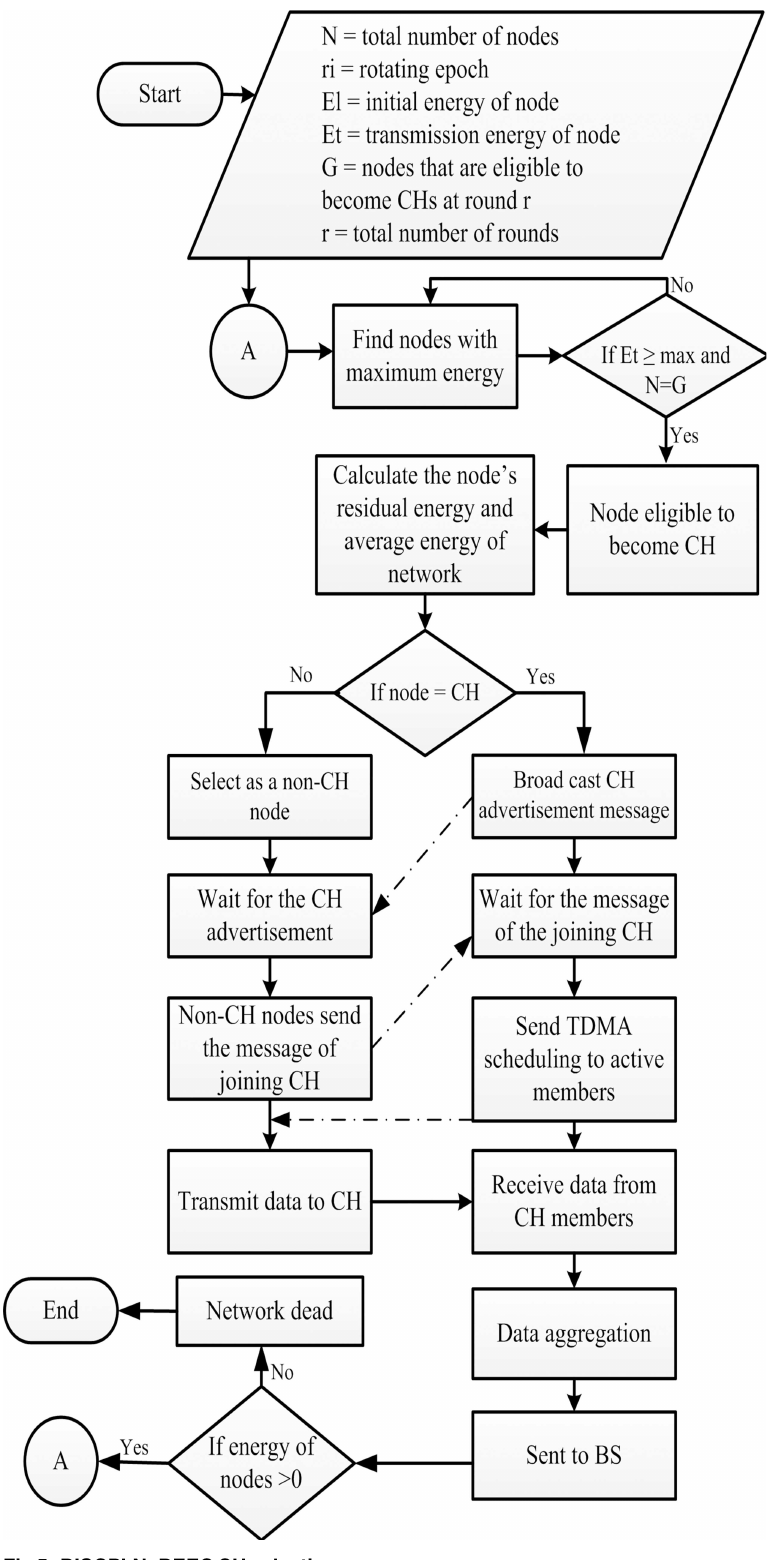
Fig 5. DISCPLN–DEECCH